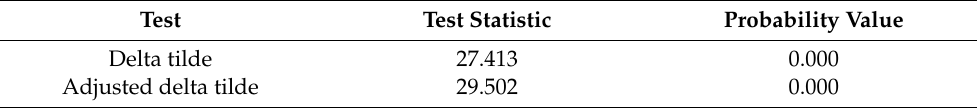
Table 4. Results of homogeneity